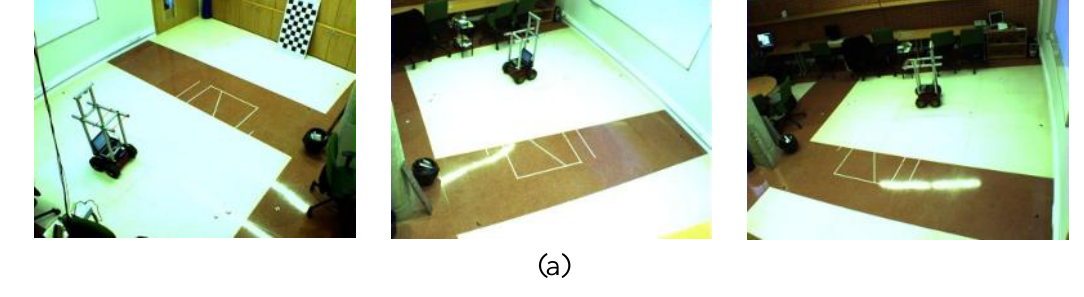
Figure 7. Images belonging to the test sequences, acquired by fixed cameras in the ISPACE-UAH. (a) Images belonging to the sequence 1 (b) Images belonging to the sequence